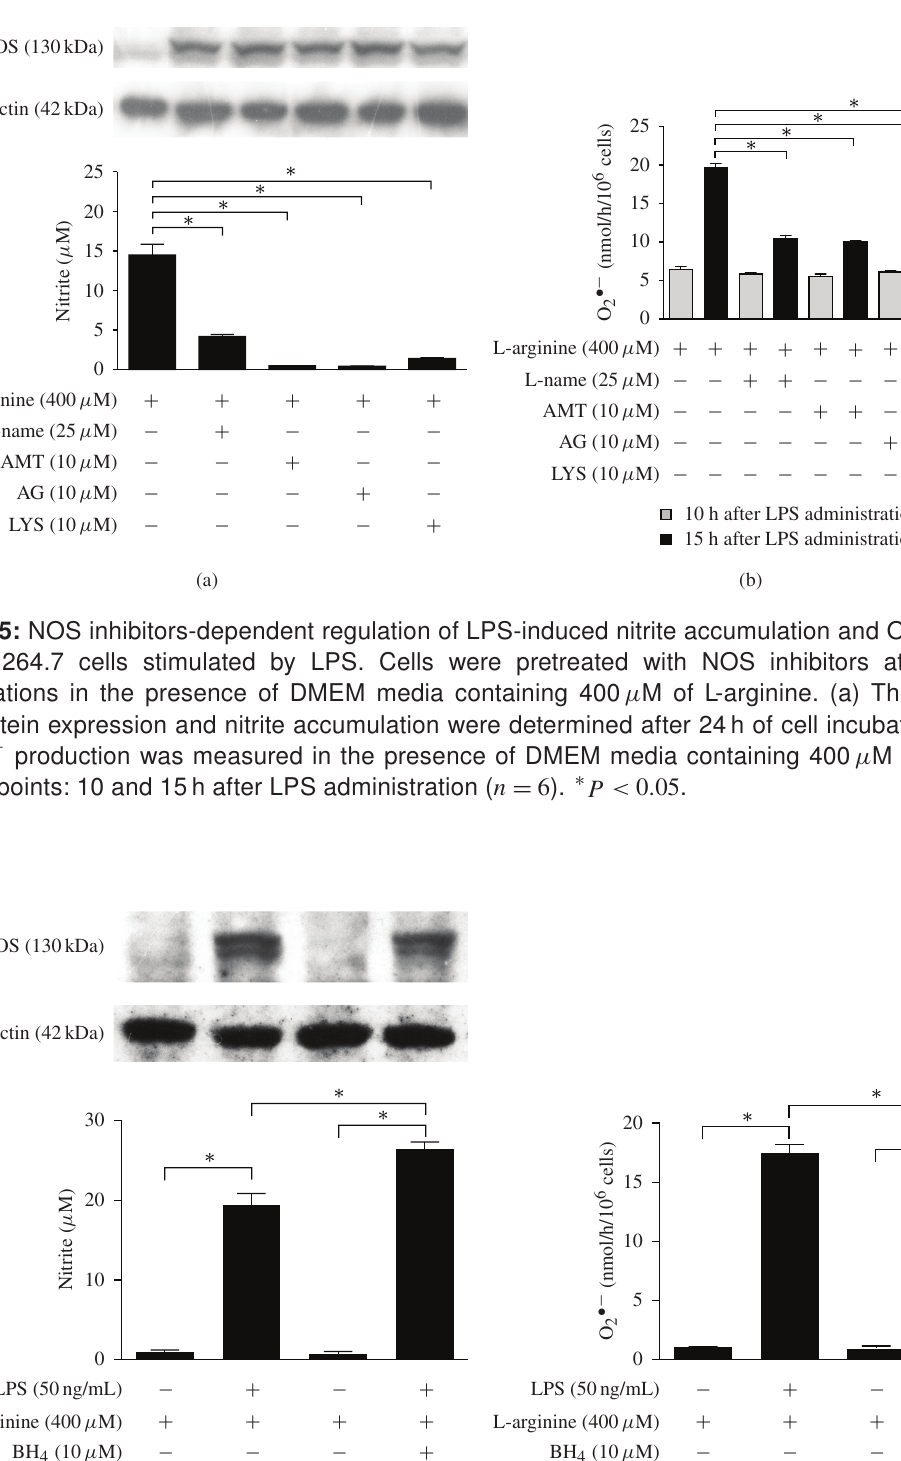
FIGURE 6: Effect of BH 4 on iNOS protein expression, nitrite accumulation, and O 2 264.7 cells. Cells were incubated with one of the essential NOS cofactors, BH 4 in the presence of DMEM media containing 400 μ M of L-arginine. iNOS protein expression in cell lysates, accumulation of nitrite •− production in cell supernatants (b) were determined after 24 h of cell incubation with LPS (a), and O 2 (50 ng/mL). Results represent means ± SEM ( n = 3 ). ∗ P < 0 . 05